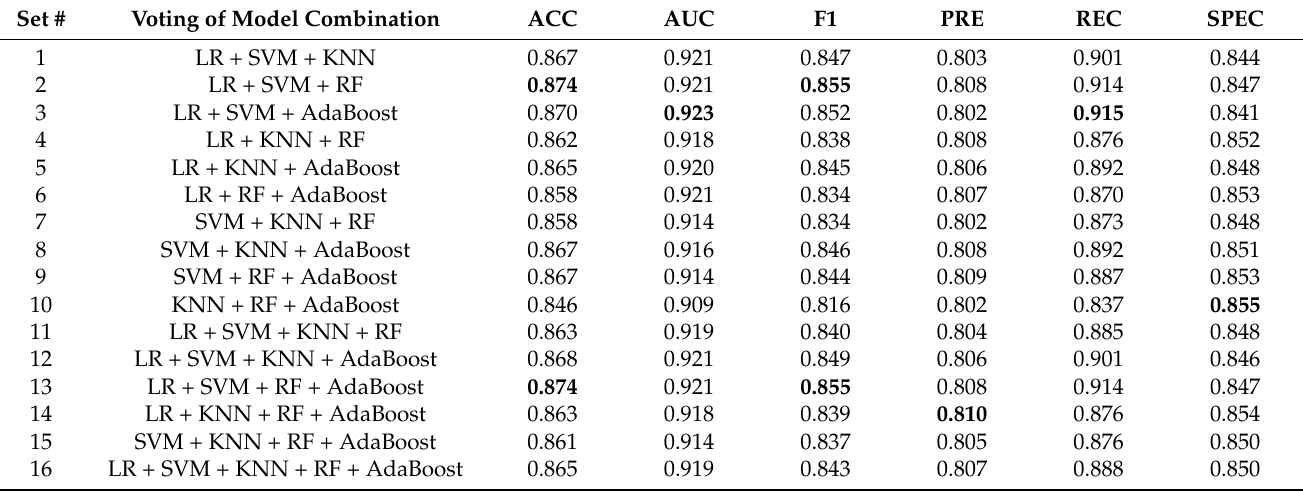
Table 9. Computational results for TGGA dataset with LASSO feature selection method and ensemble learning